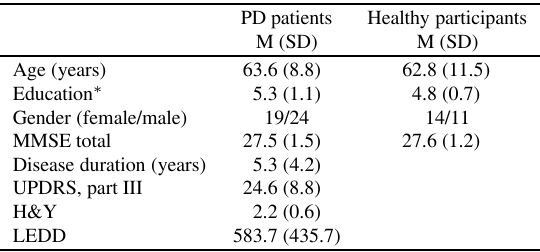
Table 1 Descriptive and disease characteristics of PD patients ( n = 43)